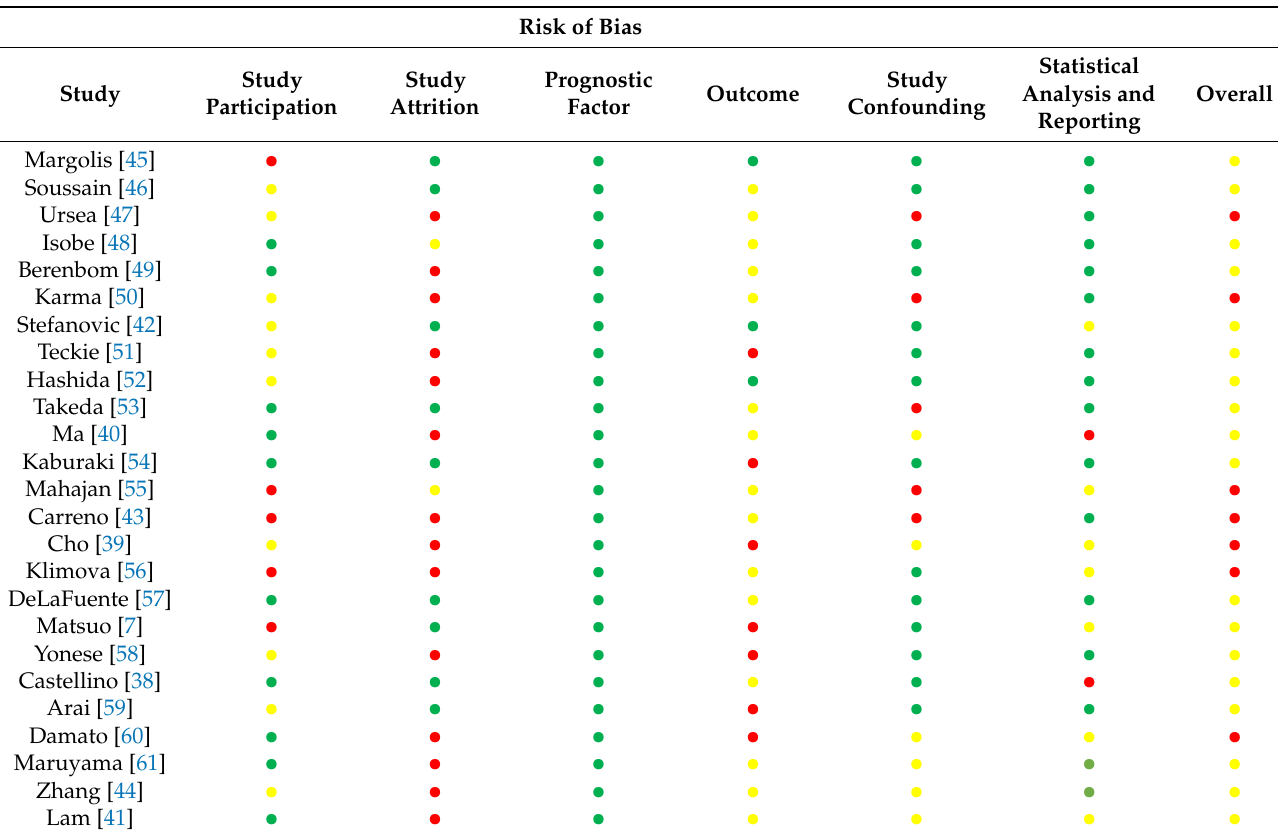
Table 2. Quality assessment of data using